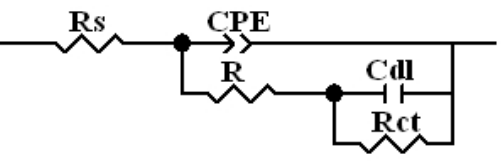
Figure 11. Equivalent electric circuit used to adjust to the experimental data of EIS.